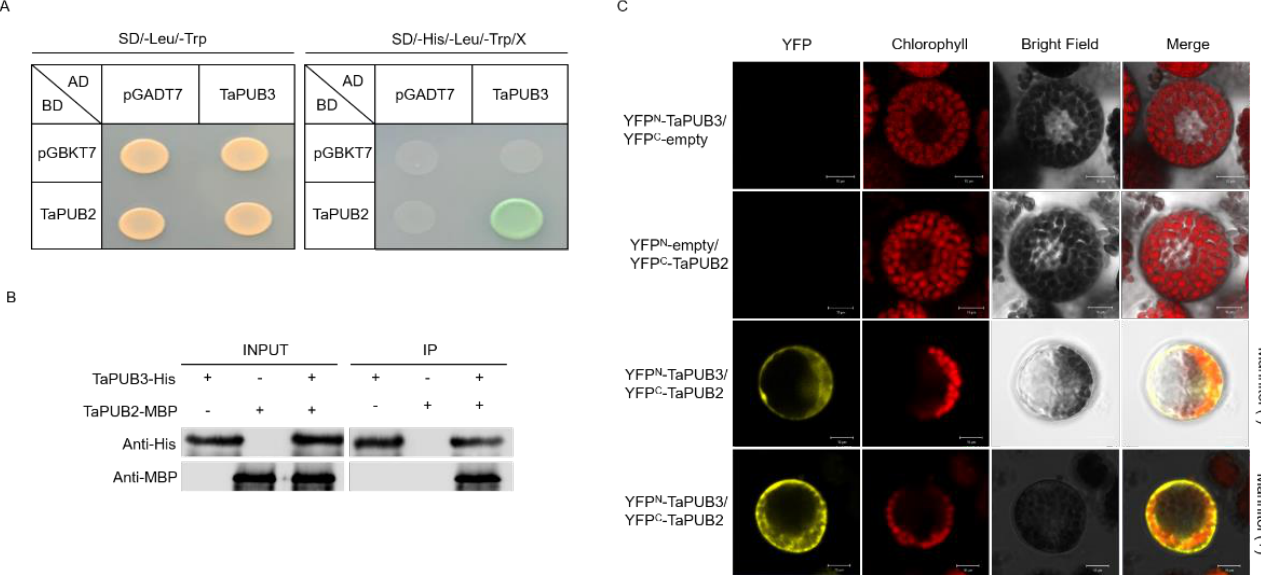
Figure 5. Heterodimeric complex formation of TaPUB2 and TaPUB3. ( A ) Yeast two-hybrid assay with TaPUB2 and TaPUB3. Full-length cDNA fragments encoding TaPUB2 and TaPUB3 were fused to sequences encoding GAL4 DNA-binding domain (BD) and GAL4 activation domain (AD) in pGBKT7 and pGADT7, respectively. Each construction was co-transformed into AH109 yeast strain in SD/-Leu/-Trp and SD/-Lue/-Trp/-His/-Ade/X-a-gal media. (B) In vitro pull-down assay of TaPUB3-His protein and MBP-TaPUB2 protein. ( C ) BiFC assay of TaPUB2 and TaPUB3 interactions using protoplast cells. TaPUB2 was fused into C -terminal YFP, and TaPUB3 was fused into N -terminal YFP. A confocal laser scanning microscope was used to detect the fluorescence signal.